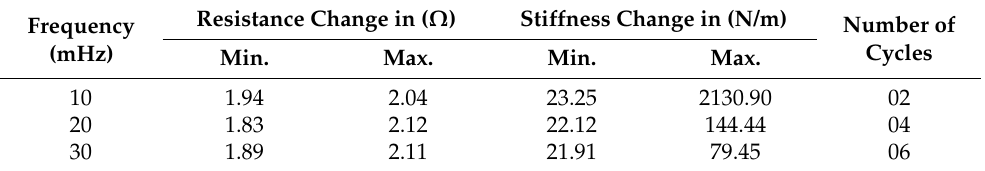
Table 13. Stiffness and resistance at different frequencies.